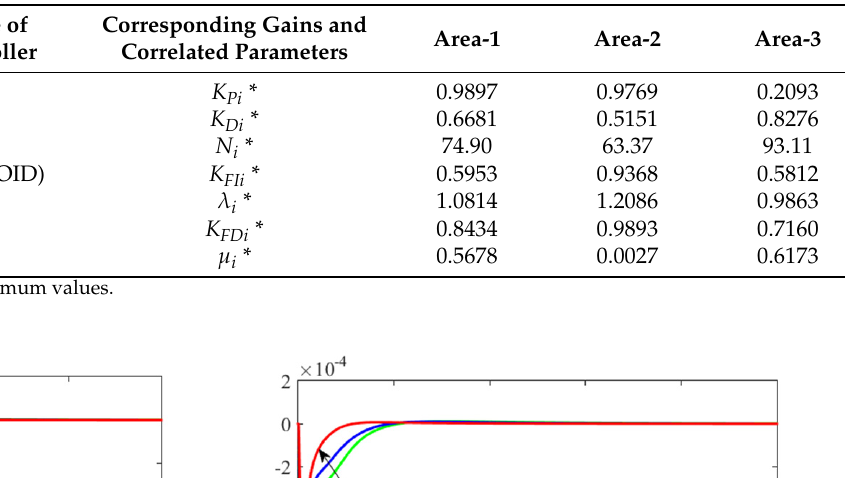
Table 8. Finest values of gains and related parameters of PDN(FOID) controllers for scheme-5 (thermal–